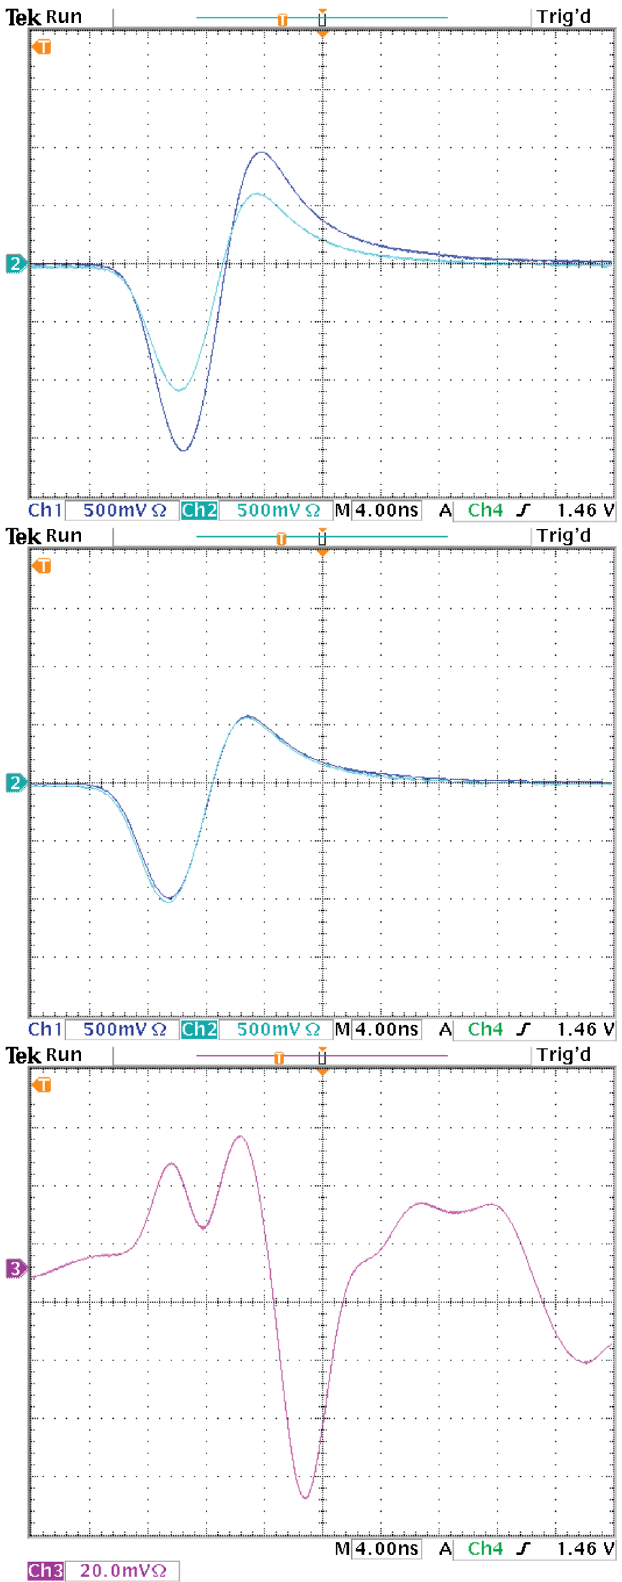
FIG. 3. BPM signals A (blue) and B (cyan) for an antiproton bunch (top); same signals after equalization (center); A (cid:2) B out- put of the hybrid circuit after amplification (magenta,